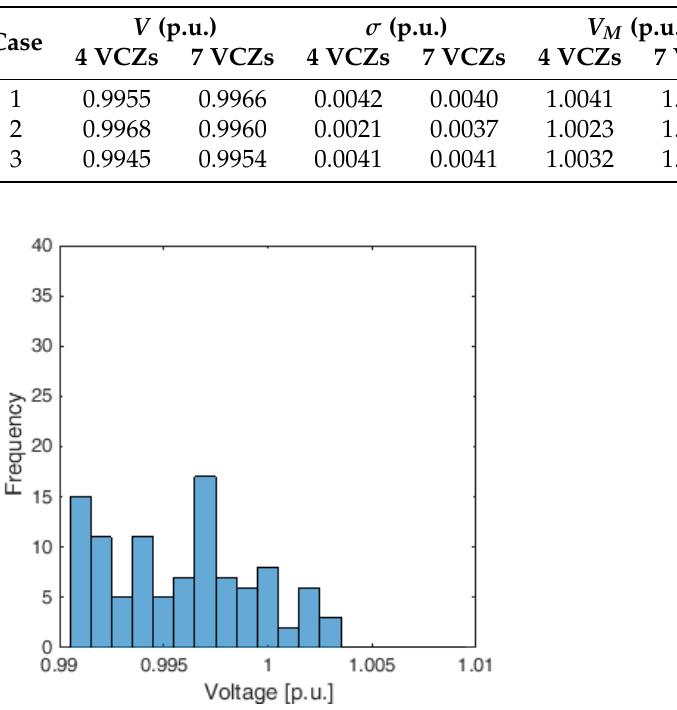
Table 10. Statistical parameters of the distribution of the nodal voltage amplitudes for the partitioning in four VCZs and seven VCZs provided by Decentralized APP .